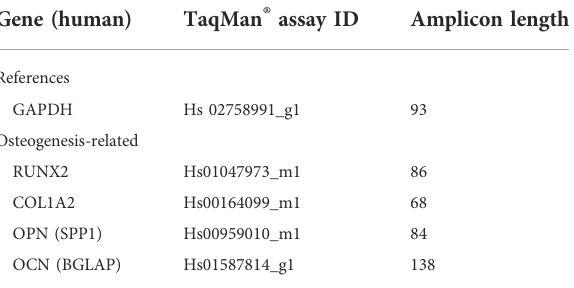
TABLE 1 Real time qPCR